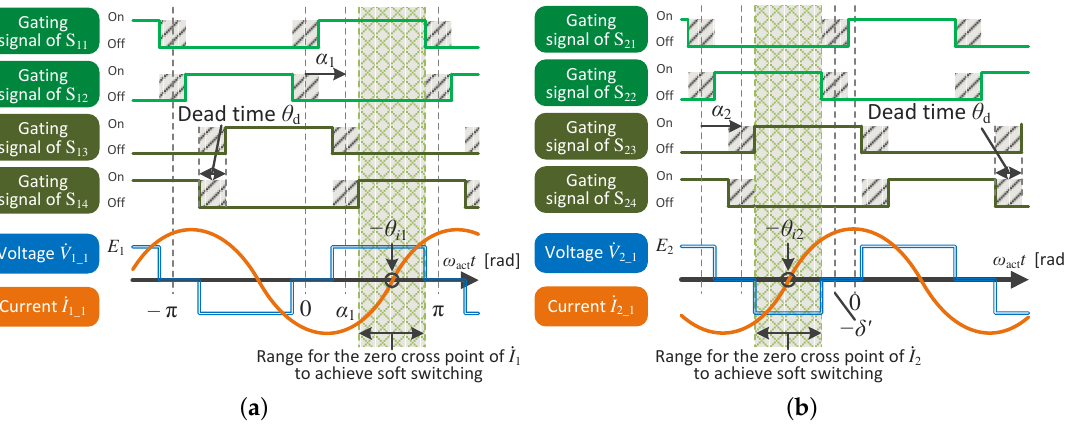
Figure 2. Relationships between the gating signals and the output waveforms of the active bridges with soft-switching operation. ( a ) operation waveforms of the primary-side active bridge; ( b ) operation waveforms of the secondary-side active